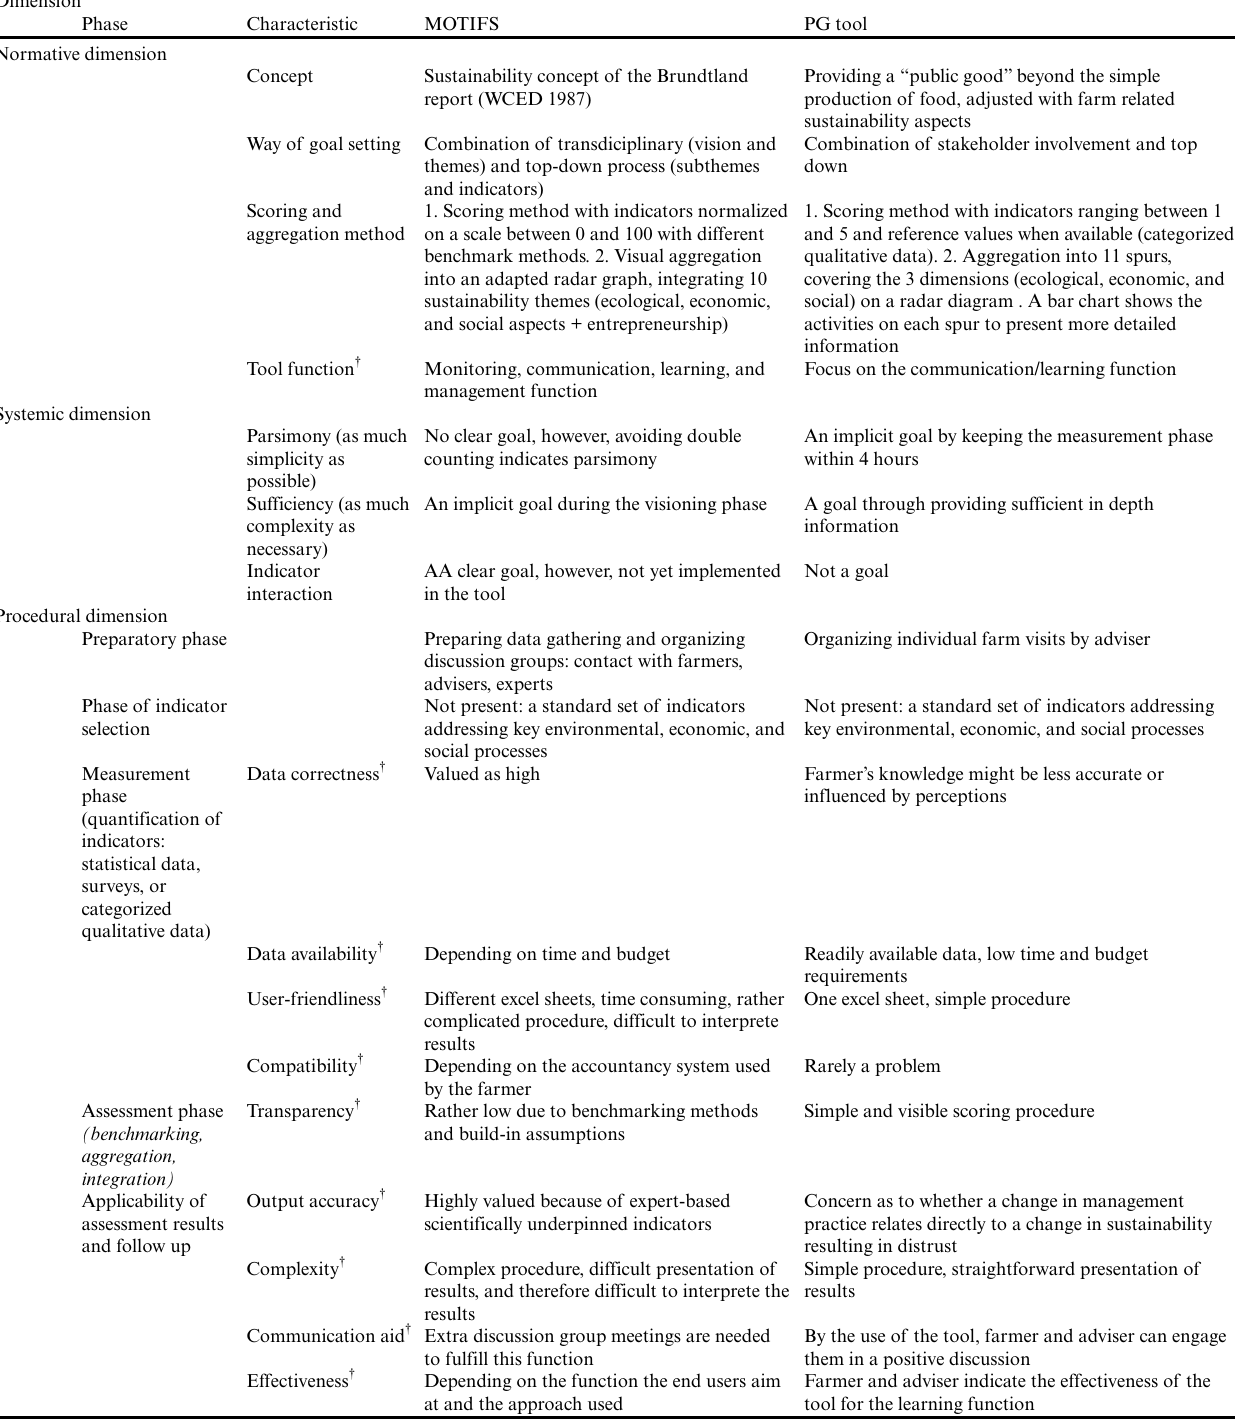
Table 3 . Comparative analysis of two integrative indicator-based sustainability assessment tools based on a framework adapted from Binder et al.